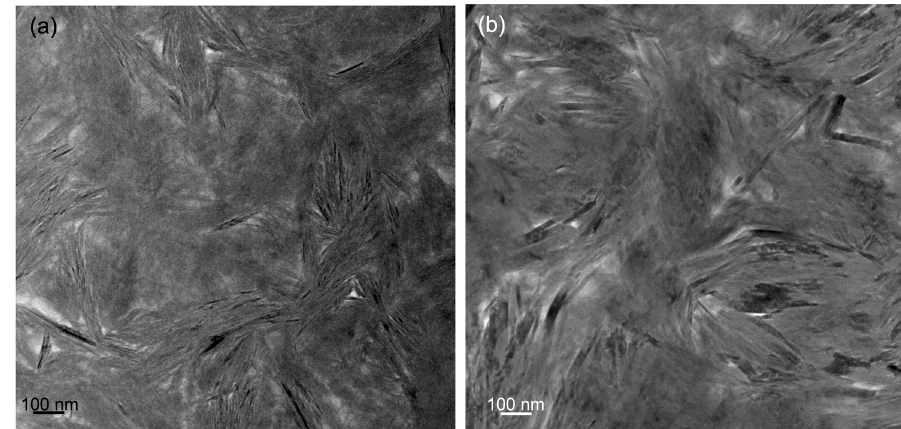
Figure 5. TEM low-magnification images showing the general aspect of glauconitic zone (a) and celadonitic zone (b) .